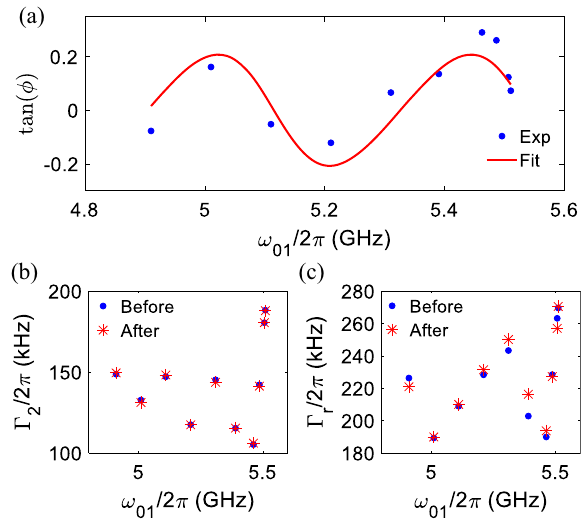
Fig. 9 Compensating the Fano-shape re fl ection coef fi cient. a The phase ϕ in Eq. (4) vs. different qubit frequencies. Blue dots are the data with the solid curve as a fi t. b , c The comparison of Γ 2 and Γ r before and after compensating the impedance mismatch.